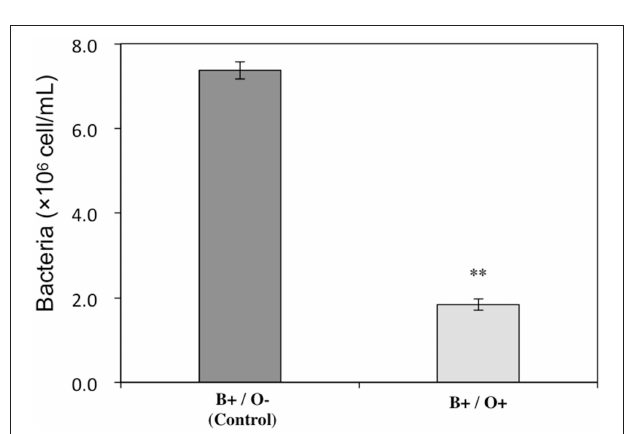
FIGURE 4 | Inhibitory effect of Ochromonas sp. on the bacteria cocultured with A. tamarense . “O” indicates Ochromonas sp.; “B” indicates bacteria; “ + ” indicates present; “ − ” indicates absent. The asterisks ** denoted statistical significance with p -values less than 0.01. All error bars indicate the SE of the three biological